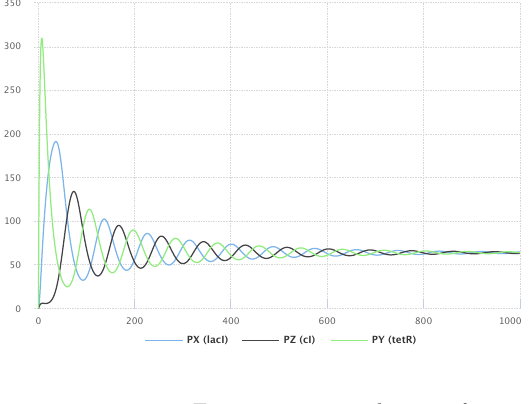
Figure 1.3: Time-course simulation of the repressilator after changing param- eters tps repr and tps active . Simula- tion with SED-ML web tools [2].